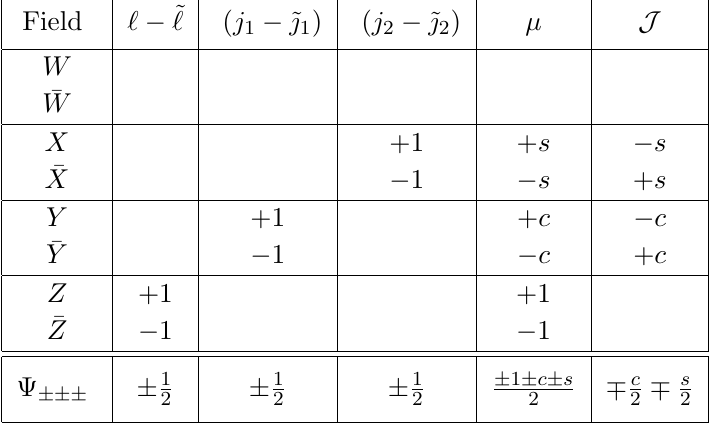
Table 1 . We list the spins of the bosonic excitations W; X; Y; Z and of their conjugate, as well as of the eight physical fermions of the Green-Schwarz string, see ref. [63]. Spins are quantised in